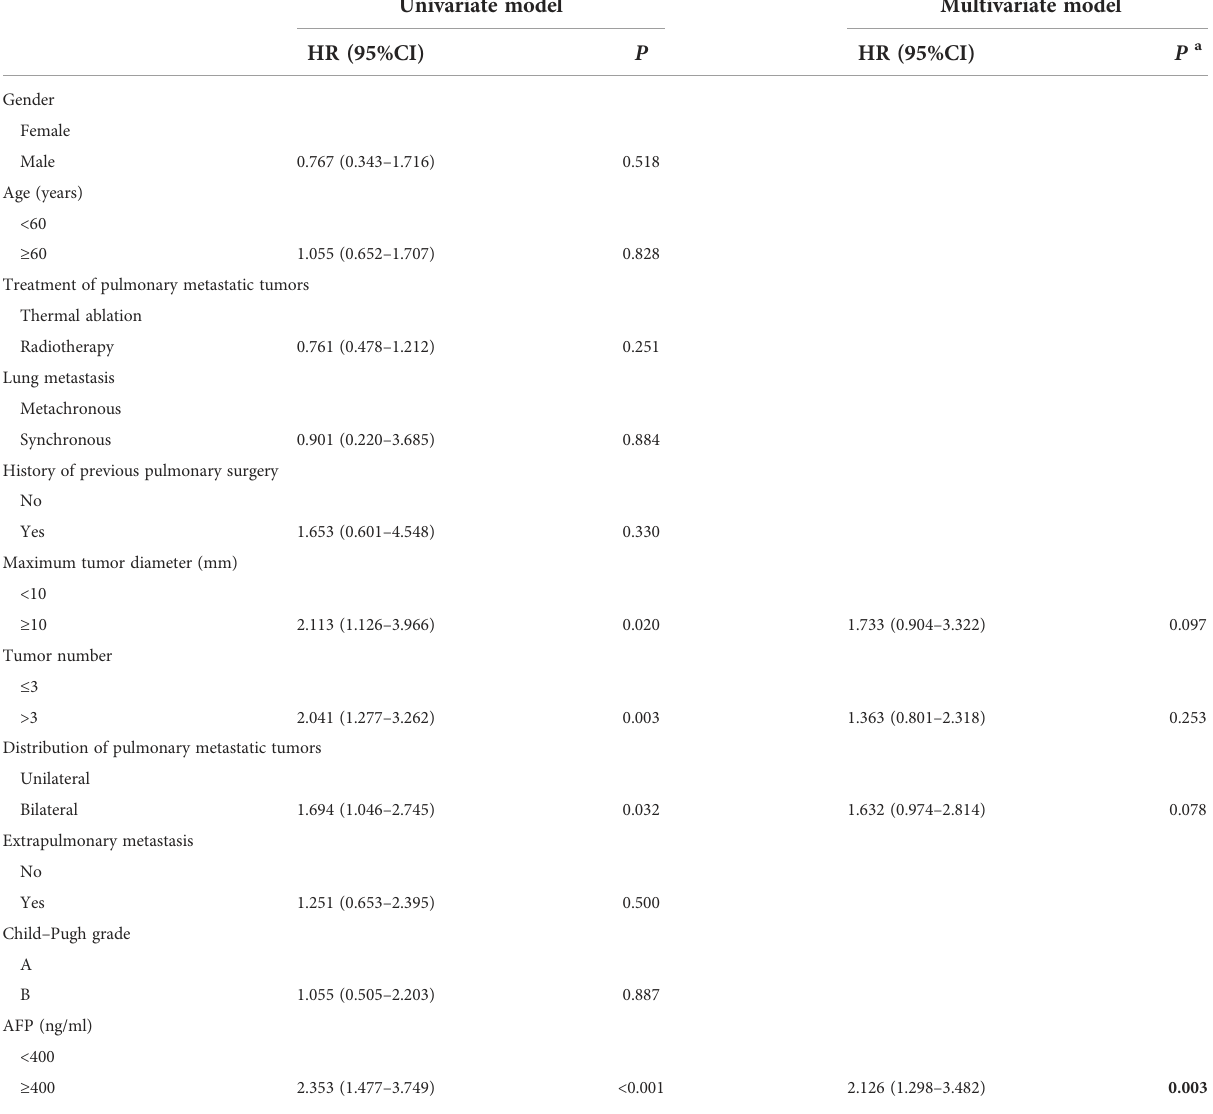
TABLE 2 Univariate and multivariate analyses of prognostic factors for local tumor progression-free